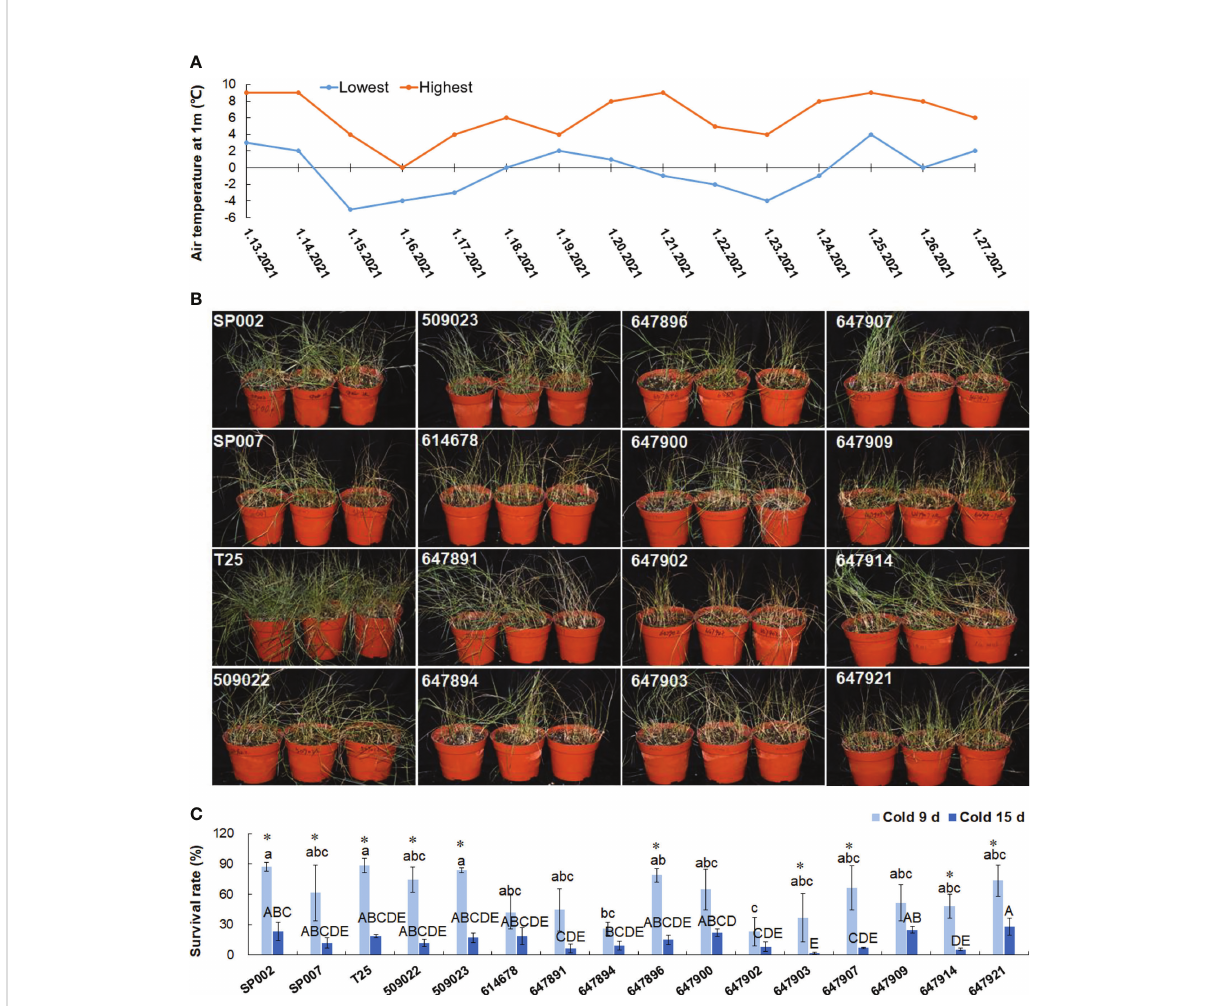
FIGURE 8 Analysis of low temperature tolerance in 16 seashore paspalum ecotypes. Temperature change diagram of plants treated with low temperature for 15 d (A) . Plants were photographed after 9 d under low temperature treatment (B) . Survival rates were respectively documented for 9 and 15 d (C) . Means of three replicates and standard errors are presented; the same letter above the column indicates no signi fi cant difference at P <0.05. Lowercase letters and uppercase letters respectively indicate signi fi cant comparisons among different ecotypes in cold 9 d and cold 15 d. * indicates signi fi cant difference at P <0.05 by T-test between cold 9 d treatment and cold 15 d treatment for 16